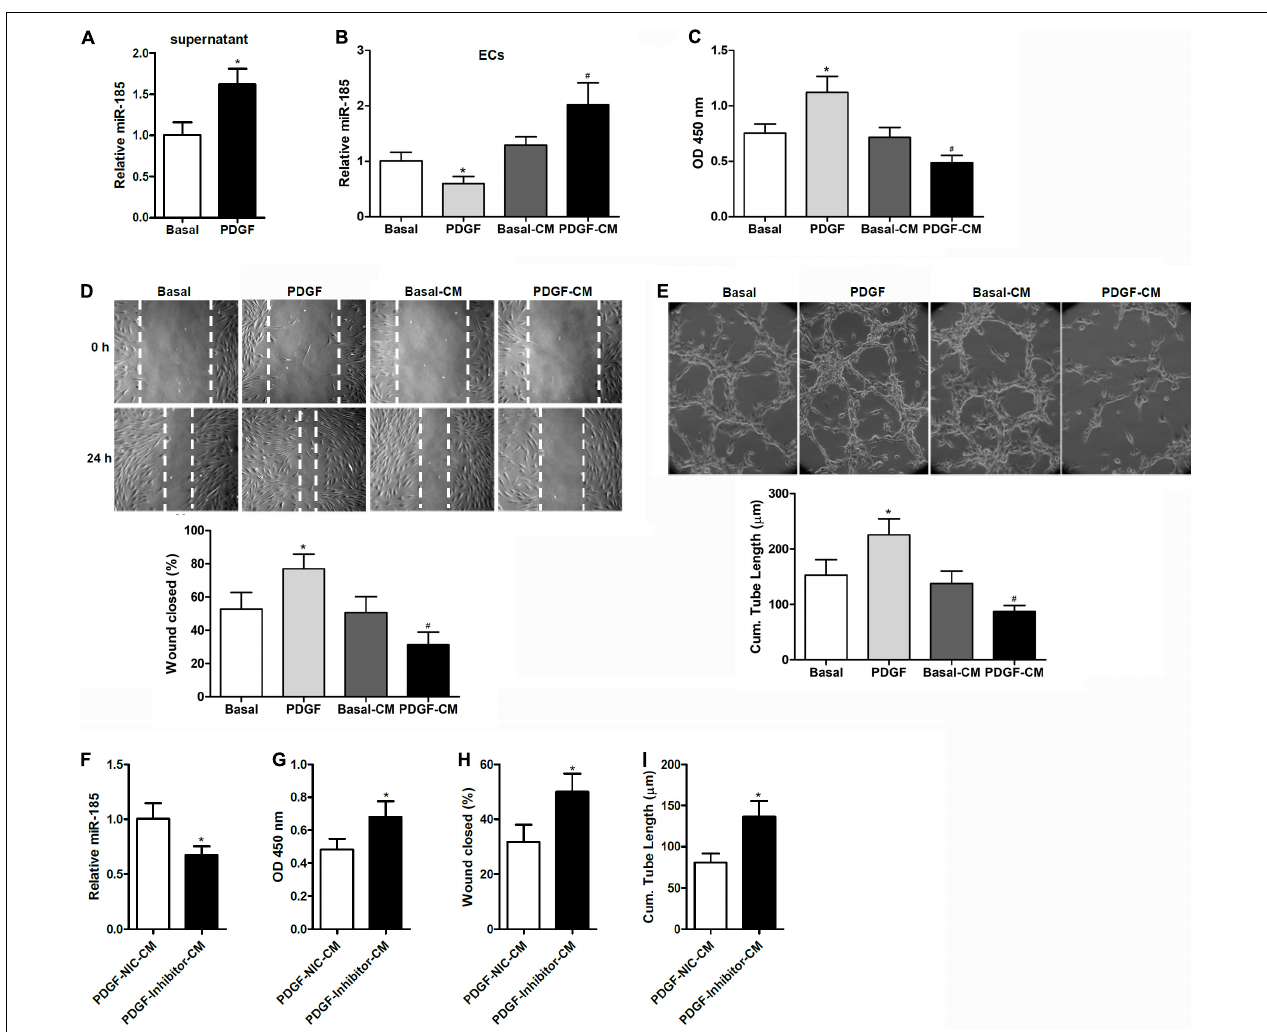
FIGURE 1 | Conditional medium derived from VSMCs stimulated with PDGF induces miR-185 expression in ECs and attenuates angiogenesis. (A) Levels of miR-185 in the supernatant of VSMCs under basal conditions (Basal) or exposed to PDGF-BB (20 ng/ml) (PDGF) for 24 h. (B) Levels of miR-185 in ECs exposed to different media for 24 h were determined by qRT-PCR assays. Basal, basal medium; PDGF, PDGF treatment (20 ng/ml); Basal-CM, medium from VSMCs in basal conditions; PDGF-CM, medium from VSMCs after PDGF stimulation. (C) Proliferation of ECs exposed to different media for 24 h as assessed by a BrdU assay. (D) Migration of ECs exposed to different media for 24 h assessed by a scratch wound assay. Migration is expressed as the relative recovery rate of the scratch wound. (E) Angiogenesis of ECs exposed to different media for 24 h was assessed by a tube formation assay. The quantitative analysis of the tube lengths is shown. * P < 0.05 vs. Basal, # P < 0.05 vs. Basal-CM. (F–I) ECs were exposed to media from SMCVs stimulated with PDGF transfected with miR-185 inhibitor or its negative control for 24 h. Levels of miR-185 in ECs (F) , cell proliferation (G) , cell migration (H) , and tube formation (I) of ECs. * P < 0.05.